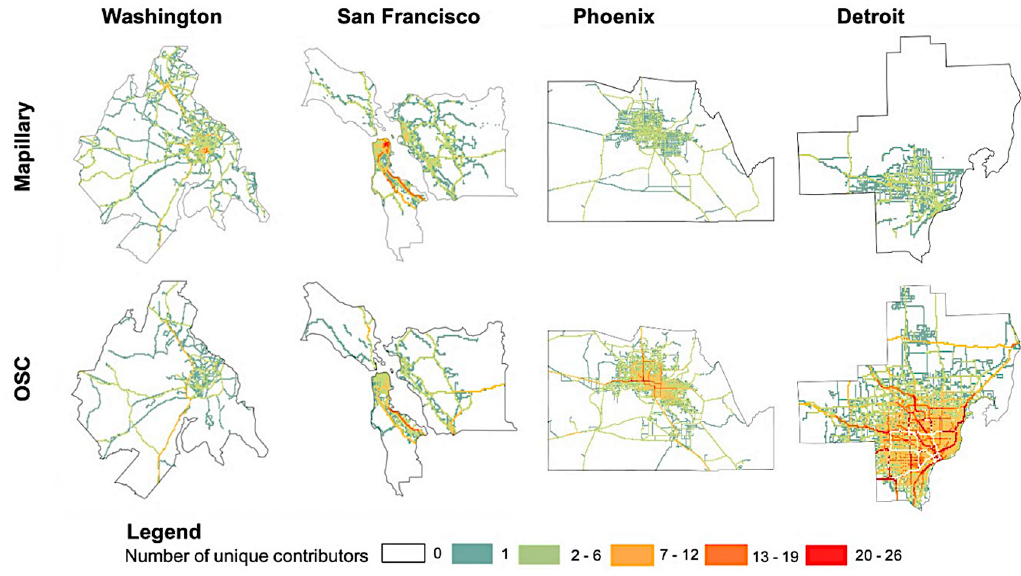
Figure 7. Unique contributors per mapped 1 × 1 km grid cell.